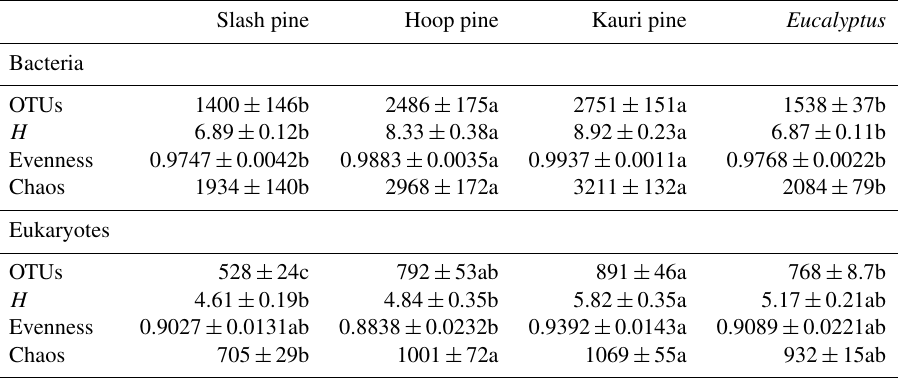
Table 3. Estimation of operational taxonomical units (OTUs), Shannon diversity index ( H ), evenness and chaos scores of soil bacterial and eukaryotes in 78-year-old forest plantations with different tree